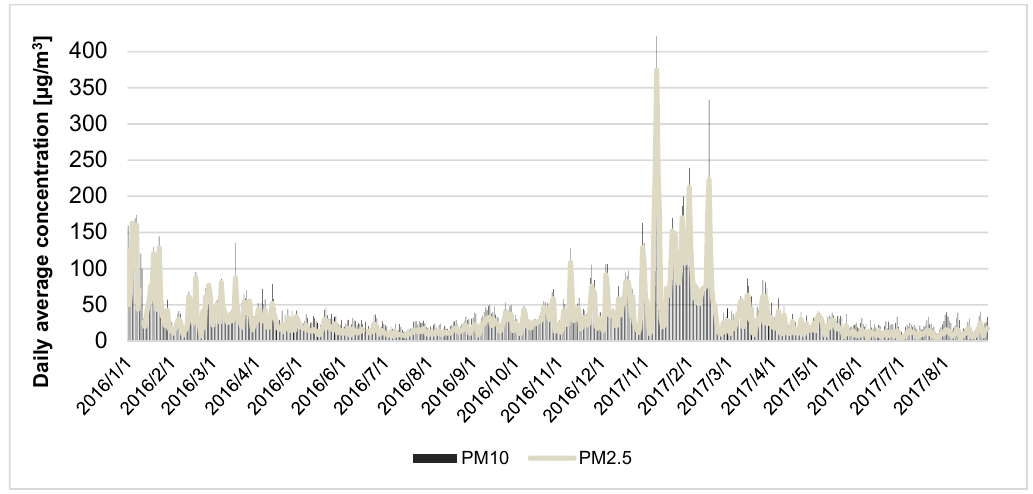
Figure 2. The daily average fine particulate matter concentration in the Silesia Agglomeration in the study period from 1 January 2016 to 31 August 2017.